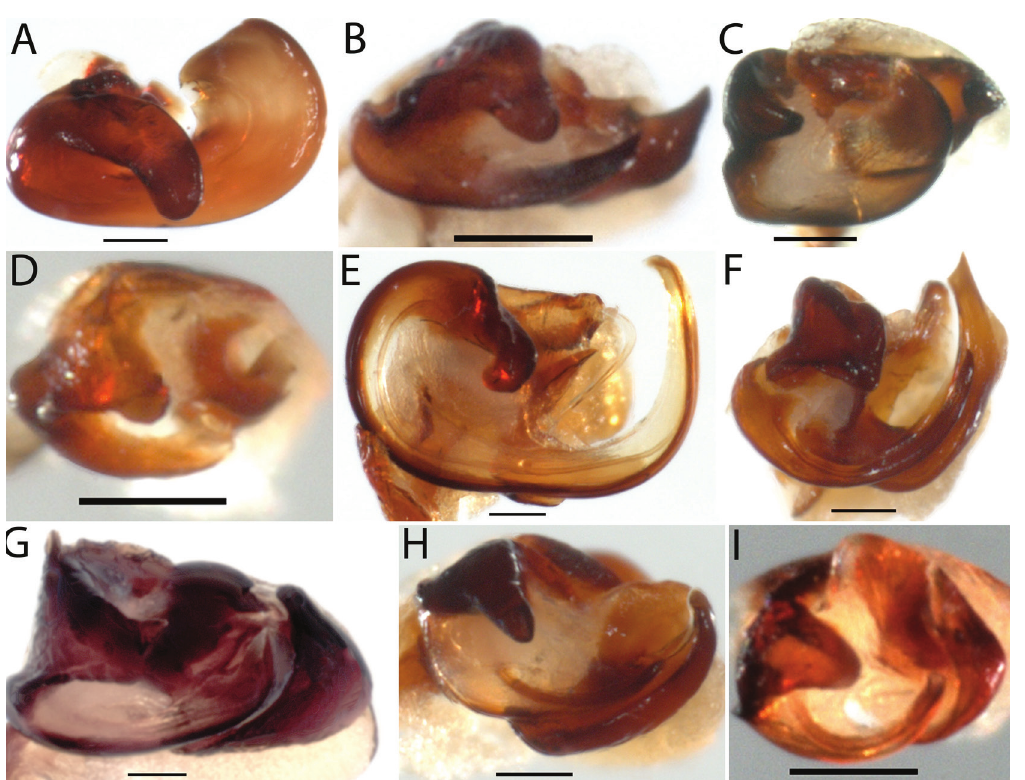
Figure 48. Artoria spp., palea of male pedipalp, ventral view: A , A. kerewong sp. n. (AM KS16162); B , A. maroota sp. n. (AM KS128075); C , A. mungo sp. n. (AM KS12773); D , A. munmorah sp. n. (AM KS128070); E, A. slatyeri sp. n. (AM KS116619); F , A. strepera sp. n. (AM KS48719); G , A. taeniifera Simon, 1909 (WAM 98/2179); H , A. terania sp. n. (AM KS10351) I , A. wilkiei sp. n. (AM KS128072). Scale bars: 0.1